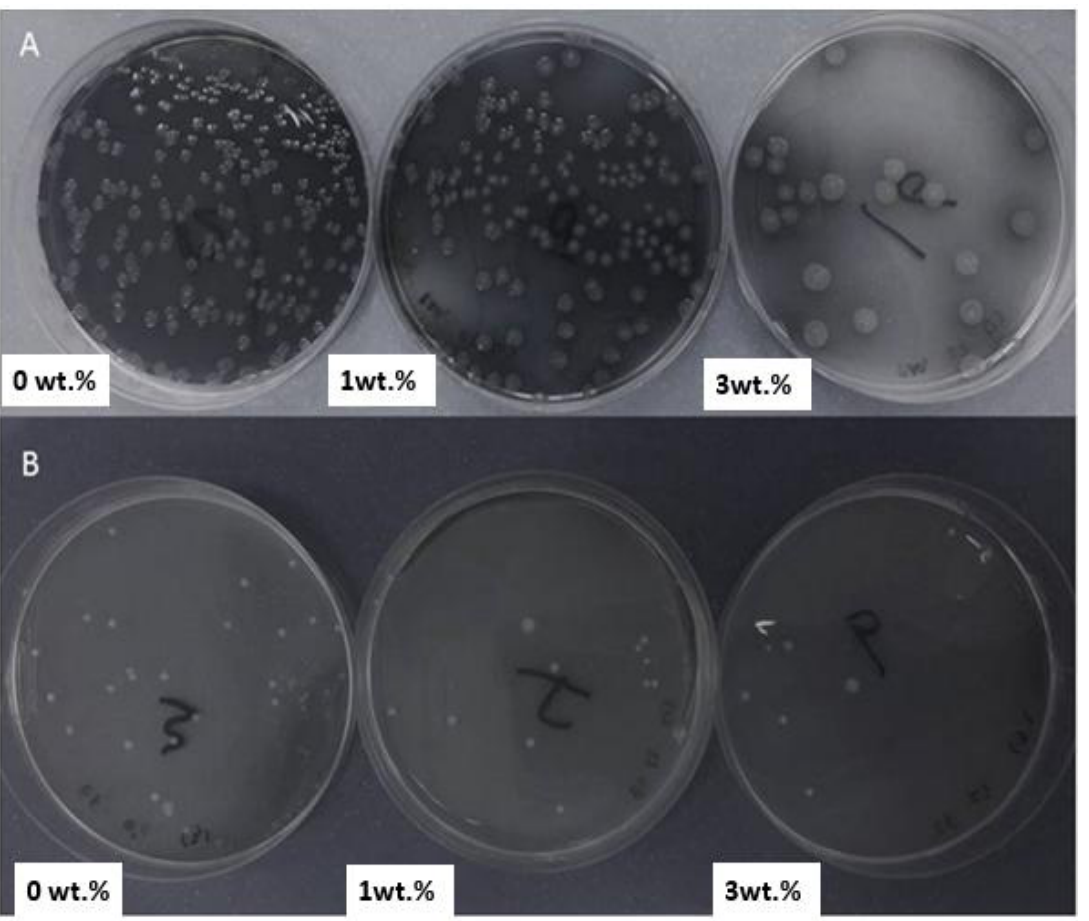
Figure 10. ( A ) C.F.U. of P. aeruginosa on nutrient agar after growing it on PMMA composites containing 0 wt. %, 1 wt. %, and 3 wt. % TiO 2 for 48 h. ( B ) C.F.U. of E. faecalis after growing it on PMMA composites containing 0 wt. %, 1 wt. %, and 3 wt. % TiO 2 .